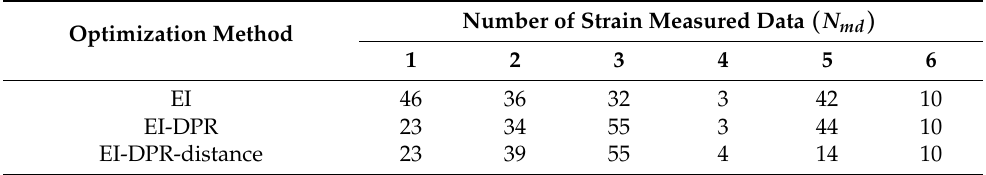
Table 5. Sensor location in the FEM model used for estimation (Case 2: strain with one